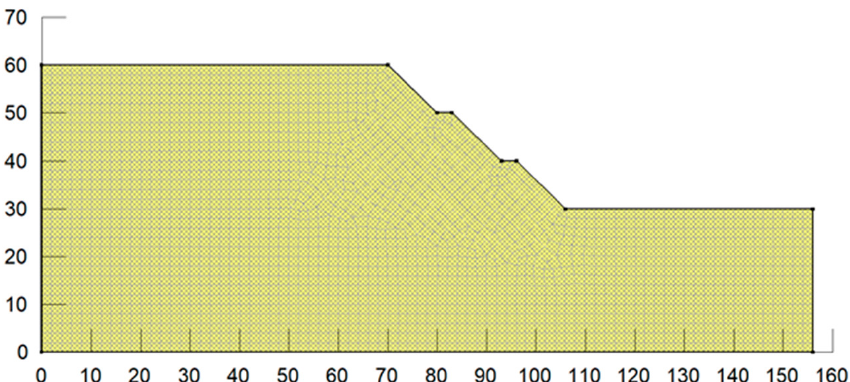
Figure 2. Grid diagram of dynamic analysis and calculation model of multi-stage loess slope under A-1 working condition.